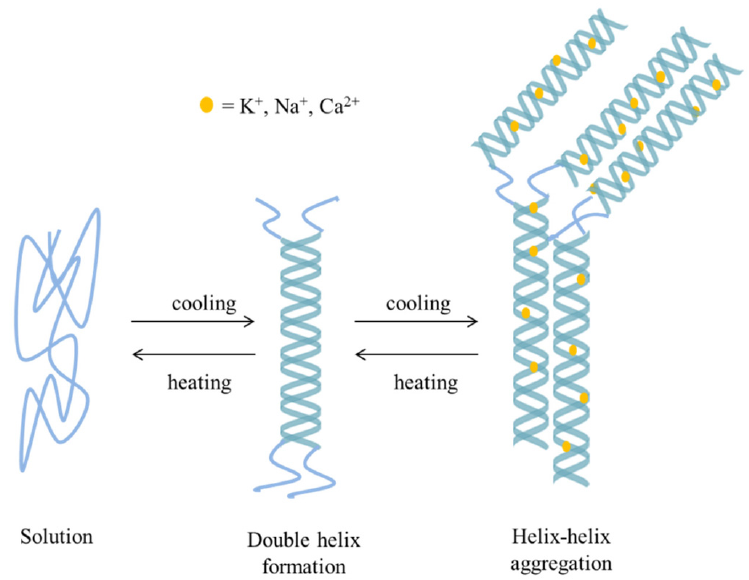
Figure 21. Scheme of carrageenan gel formation. The structure of κ - and ι -carrageenan allows segments of the two molecules to form the so-called double helices which bind the chain molecules in a three-dimension network. The associated counterions such as Na + , K + and Ca 2+ , are also required to induce the sol-gel transition of the referred types of carrageenan. Reproduced from [160].